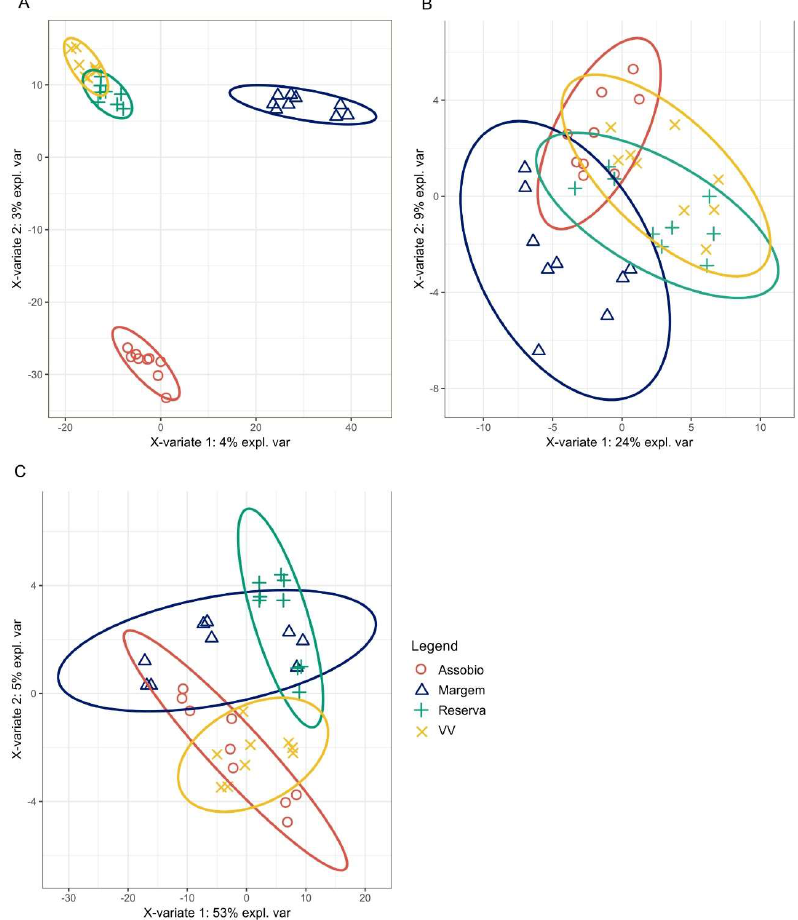
Figure 6. Partial least-squares discriminant analysis (PLS-DA) projection plots of the Terroir microbiome ( A ), Prokaryotic function ( B ) and Fungi ecology ( C ).